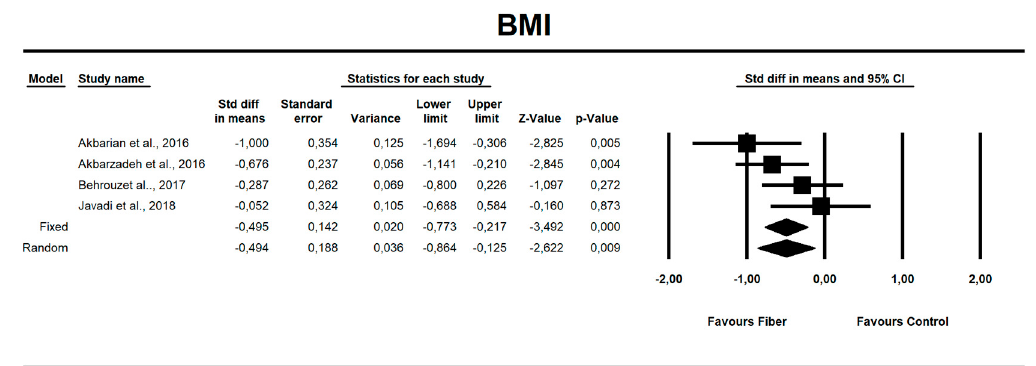
Figure 2. Effect size and standardized mean difference (SMD) for body mass index (BMI) in people supplementing fiber vs. controls. Q = 5.108, df(Q) = 3, p = 0.164, I-squared = 41.273.